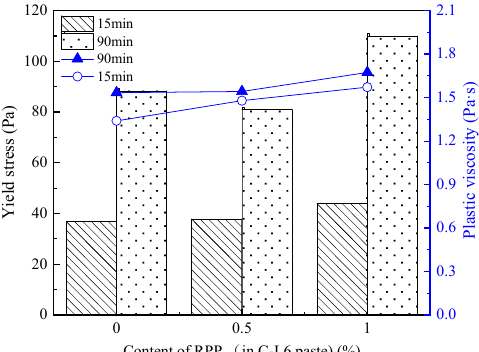
Figure 14. Yield stress and plastic viscosity of C-L6-RPP pastes.